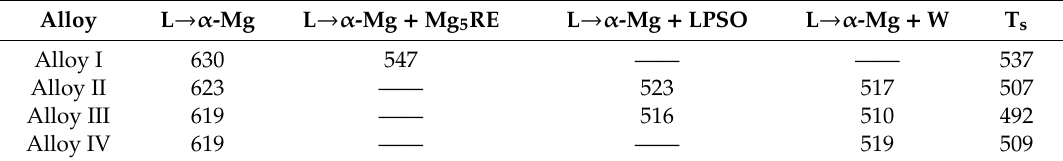
Table 2. The temperatures of phase transformation of Mg–7Gd–5Y– x Zn–0.5Zr alloys solidification path in Figure 5 (temperature, ◦